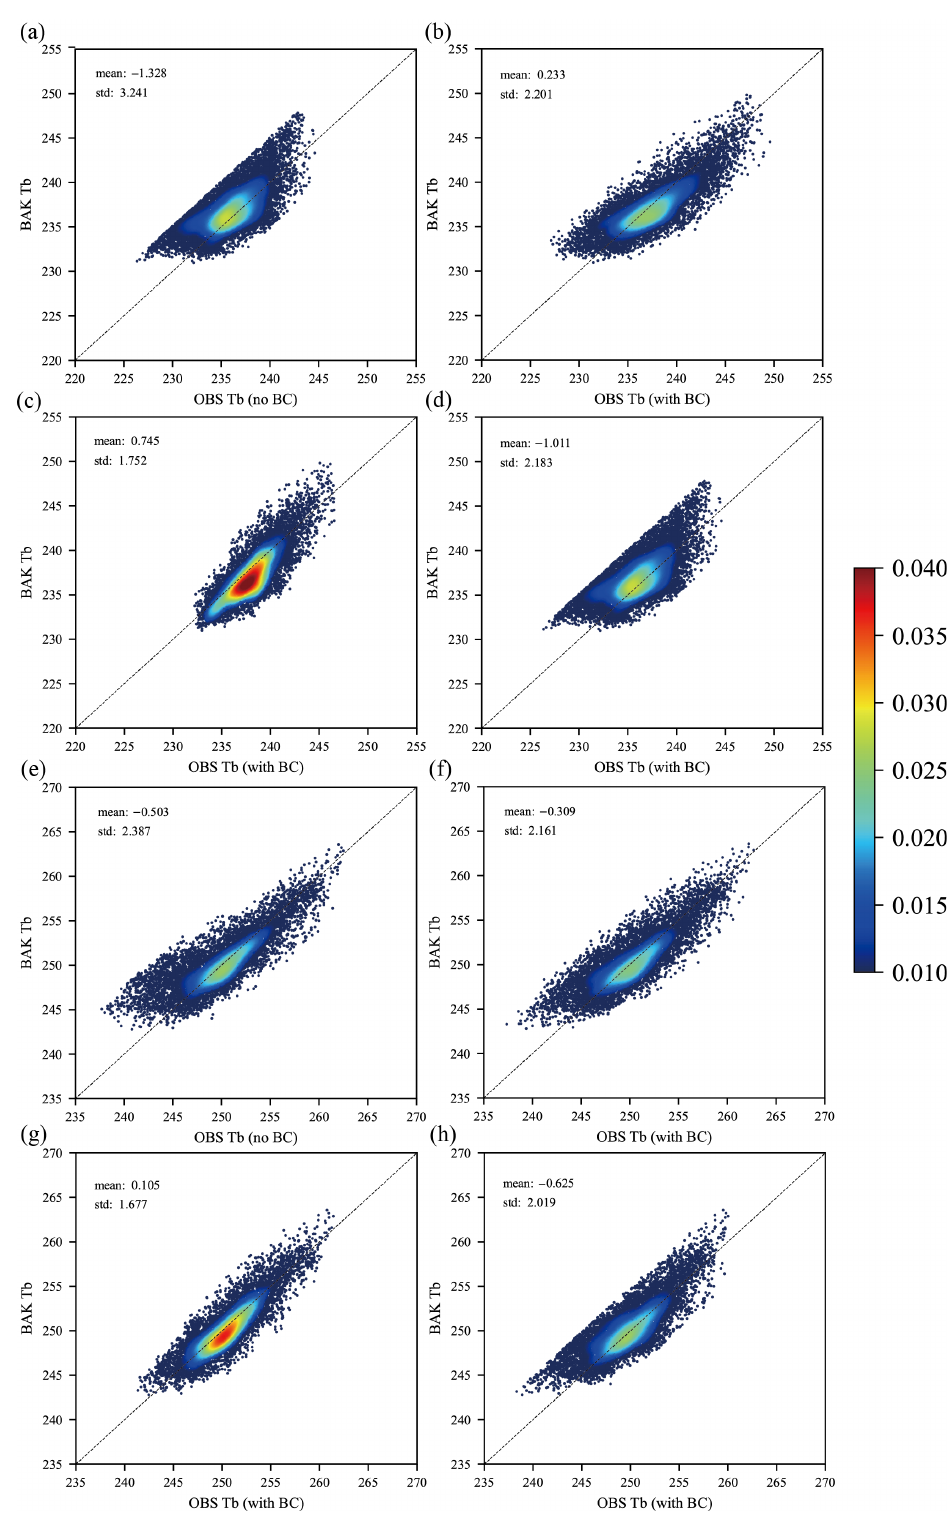
Figure 7. The QC-passed scatters of observed versus RTTOV-calculated brightness temperature (unit: K) from the background ( a ) before BC, ( b ) after BC with RF_pre4, ( c ) after BC with RF_pre7, and ( d ) after BC with Linear_pre7 for AGRI channel 9. The scatters of observed (OBS Tb) versus RTTOV-calculated brightness temperature (unit: K) from the background (BAK Tb) ( e ) before BC, ( f ) after BC with RF_pre4, ( g ) after BC with RF_pre7, and ( h ) after BC with Linear_pre7 for AGRI channel 10. The proportions of data counts are indicated as the